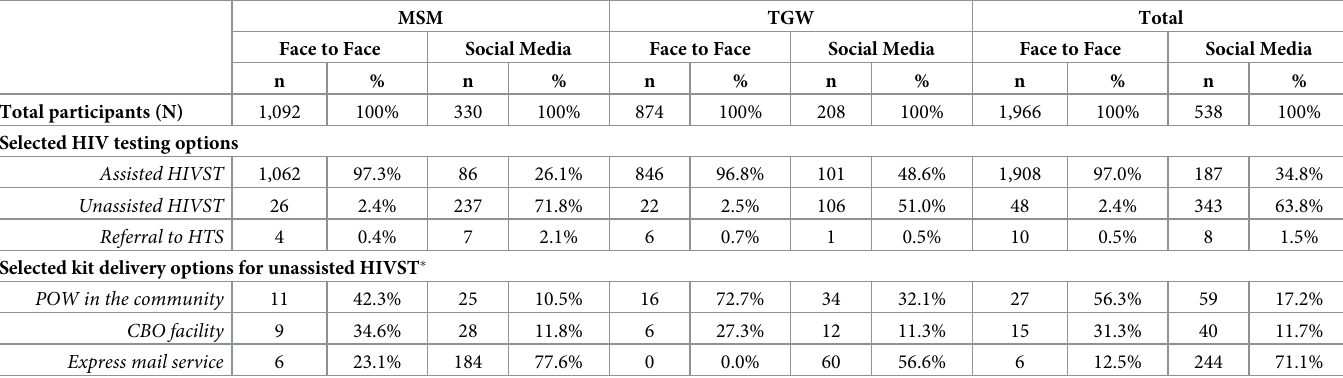
Table 5. Testing modalities by mode of